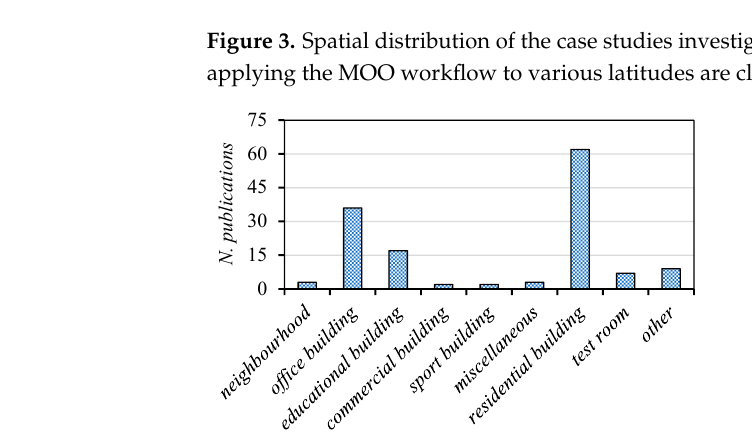
Figure 3. Spatial distribution of the case studies investigated in the reviewed journal articles. Studies applying the MOO workflow to various latitudes are clustered in the “miscellaneous” category.